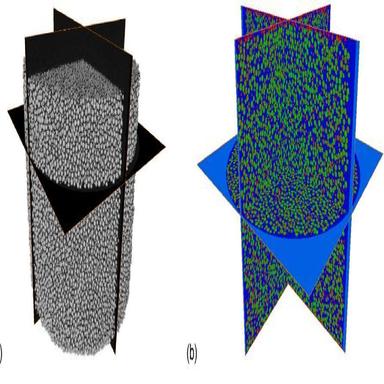
(a) 3D visualisation of µCT scanned F-NR4, which was compressed using a SHPB and (b) the result of the classification algorithm, where: dark blue is rubber; green represents the glass microspheres; and in pink are the voids. (For interpretation of the references to colour in this figure legend, the reader is referred to the Web version of this article.)